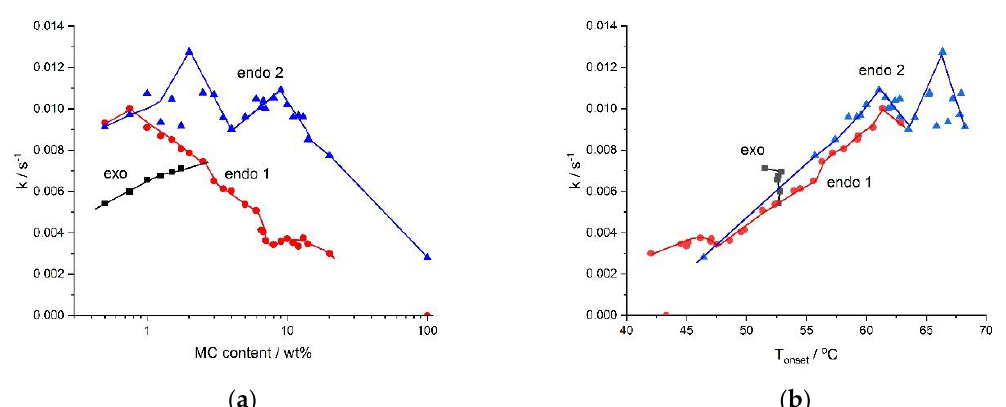
Figure 6. The rates, k , of water cages formation (exo), their destruction (endo 1), and of crosslinking (endo 2), as a function of—( a ) the MC content and ( b ) the temperature, T onset .